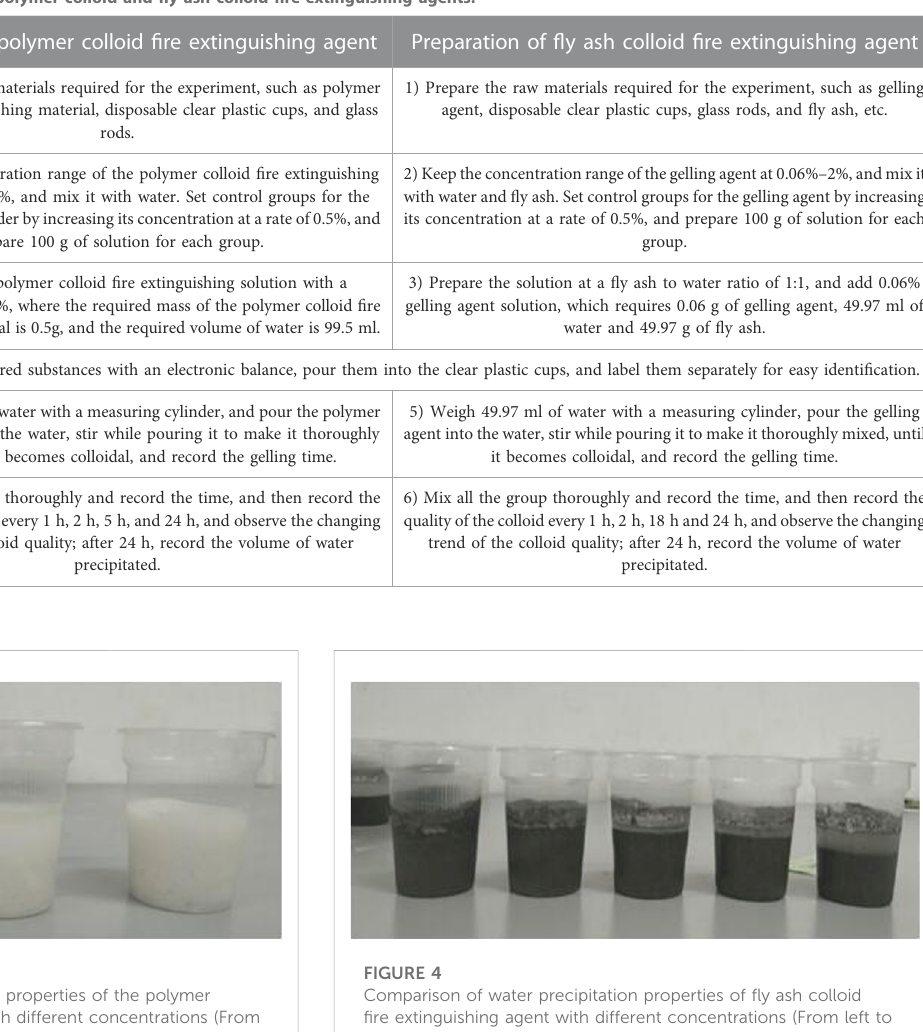
TABLE 2 Steps for the preparation of polymer colloid and fl y ash colloid fi re-extinguishing agents. Preparation of polymer colloid fi re extinguishing agent